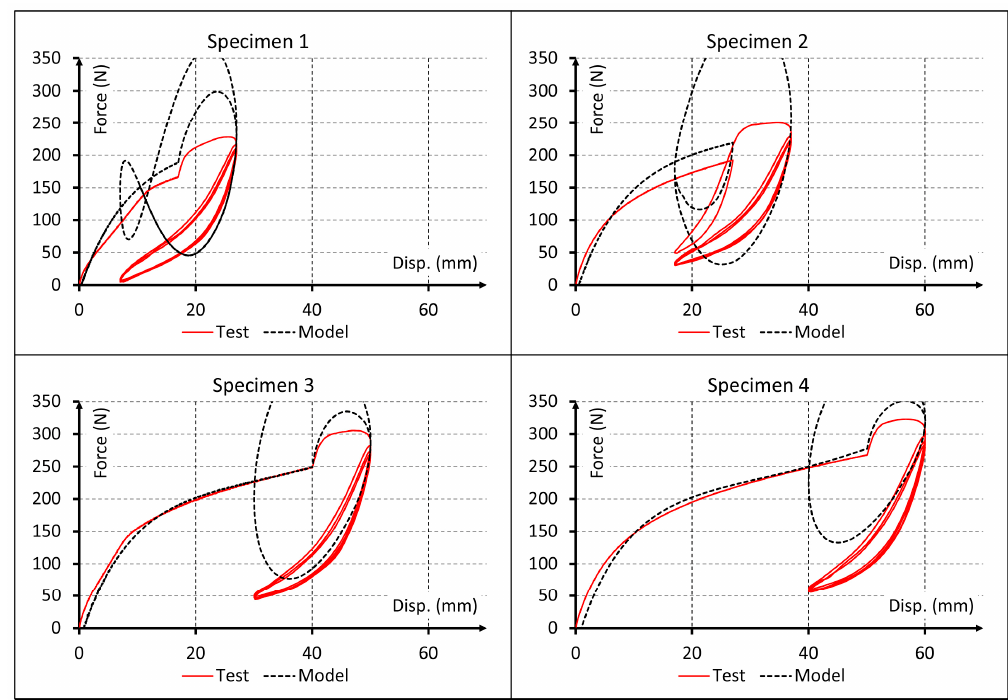
Figure 5. Comparison for first cycles between experimental data and force-displacement curves simulated using visco-hyperelastic model.